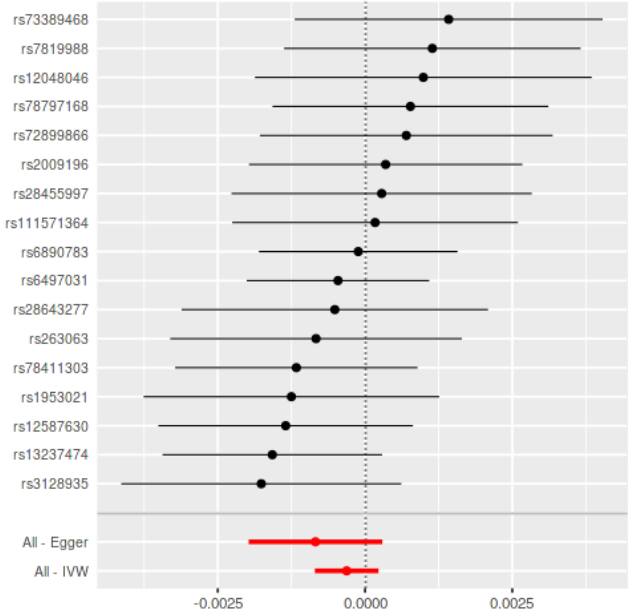
Figure 1. Mendelian Randomization summary effects for the risk of periodontitis associated with PD